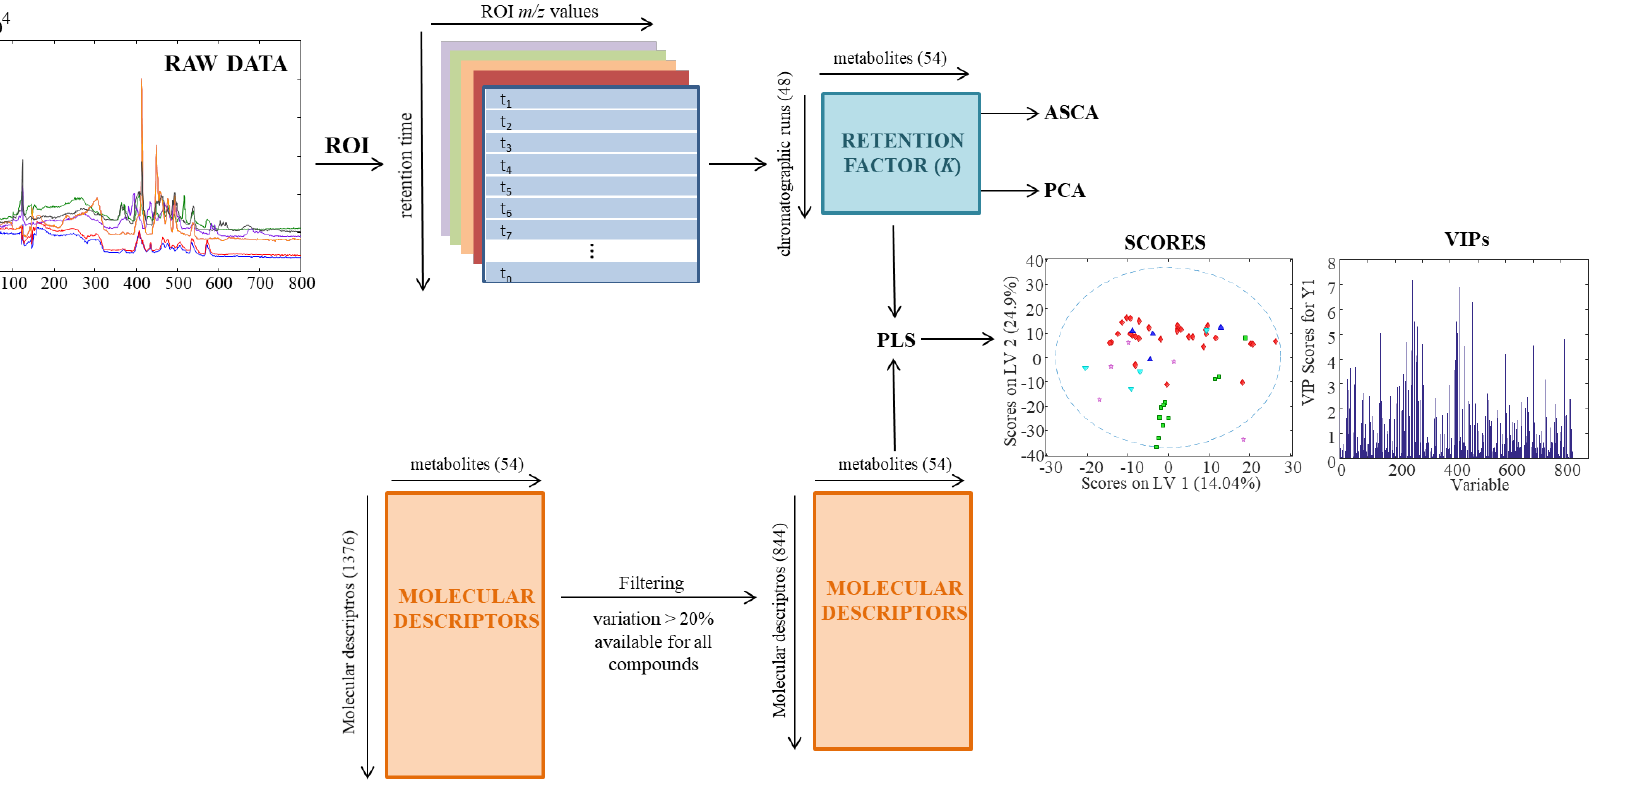
Figure 5. Scheme of data analysis strategy.